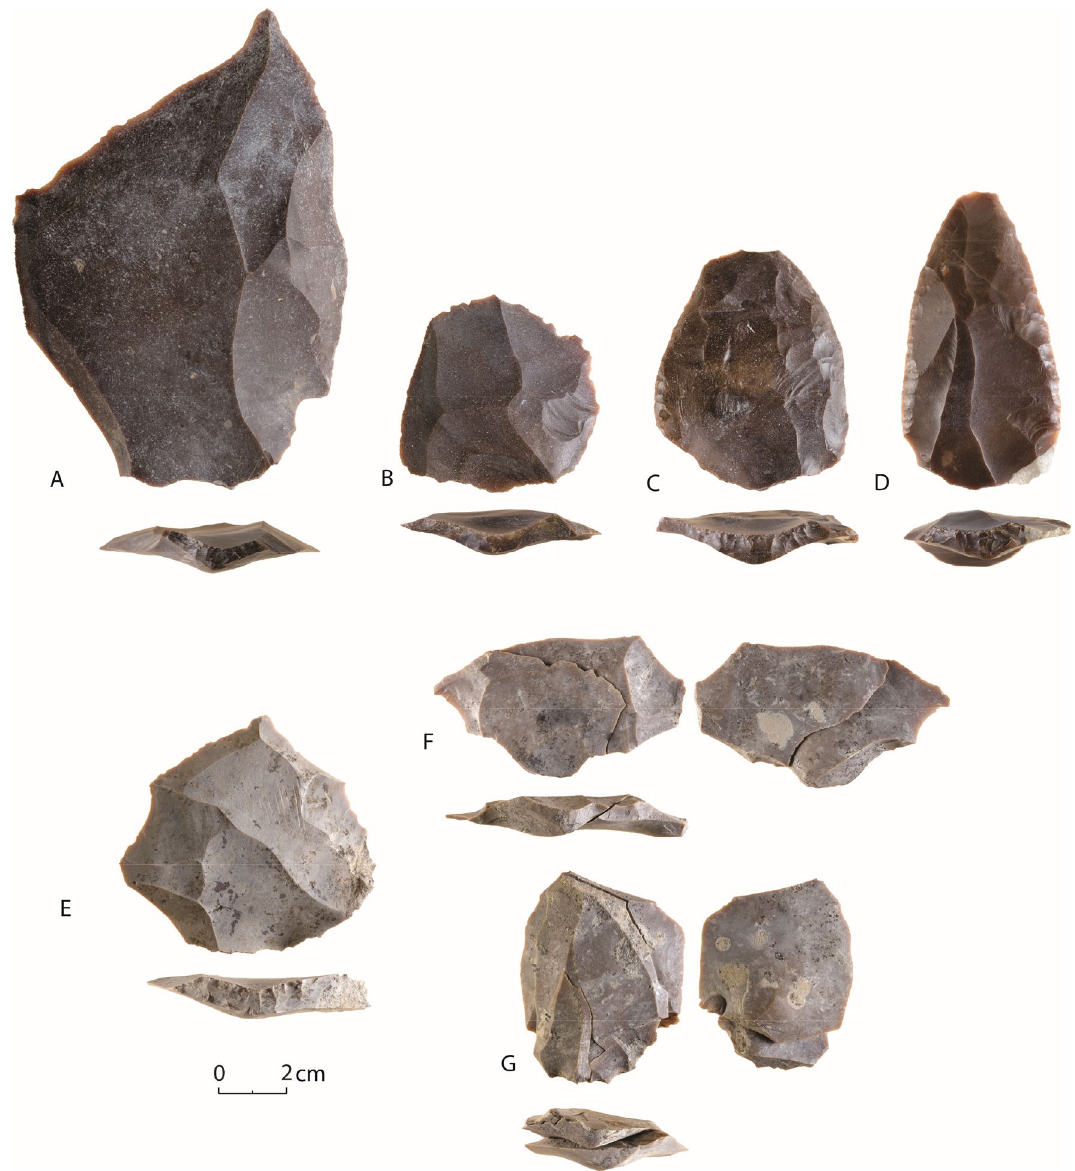
Figure 3. Characteristic lithic artifacts produced by Centripetal Levallois core technology from Nahal Aqev Unit 11 ( A – E ) and Unit 7 ( F , G ). ( A ) Large Levallois flake with bidirectional scars. ( B ) Levallois flake with a centripetal scar pattern. ( C , D ). Scrapers on Levallois flakes. ( E ) Levallois flake with a centripetal scar pattern. ( F , G ) Refitted aggregates of Levallois flakes and by products. Figure 3 was prepared by D. Gazit and C. Herch